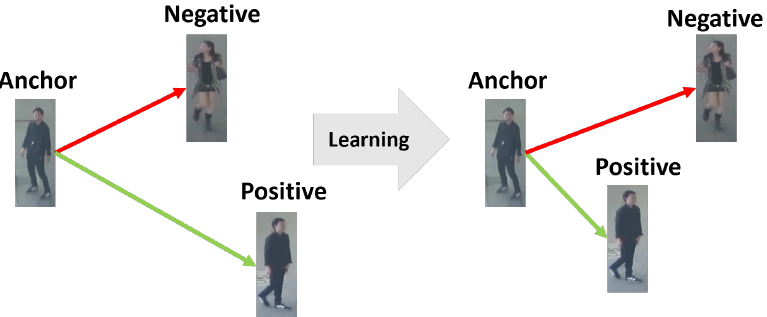
Figure 3. The change of object feature distances by using the triplet loss. The positive and the negative samples are connected with an anchor sample and indicated by green and red arrows, respectively.